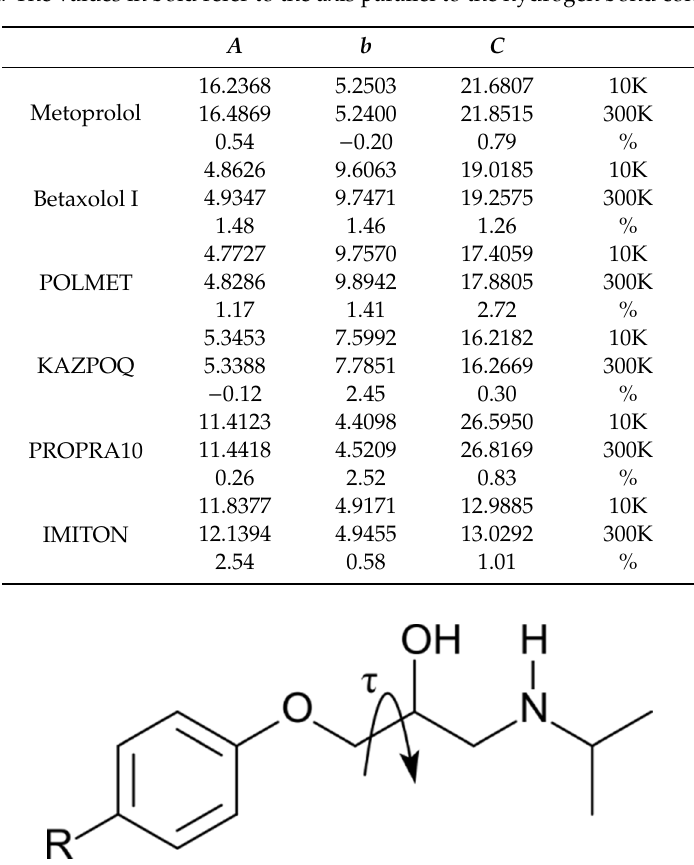
Table 1. Cell parameters (Å) at 10 K and at 300 K and their calculated variations using Quasi Harmonic Approximation. The values in bold refer to the axis parallel to the hydrogen bond